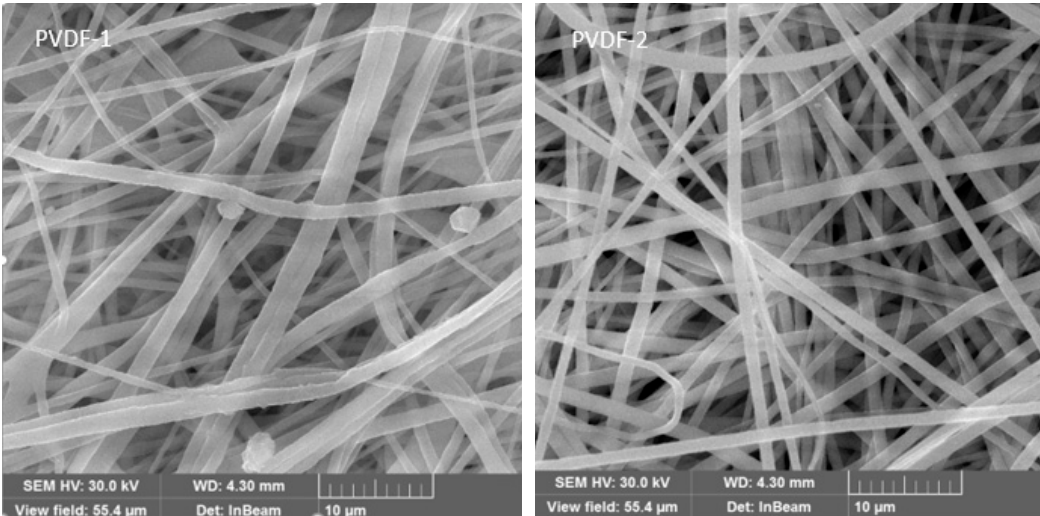
Figure 4. The SEM images of the electrospun PVDF membranes.